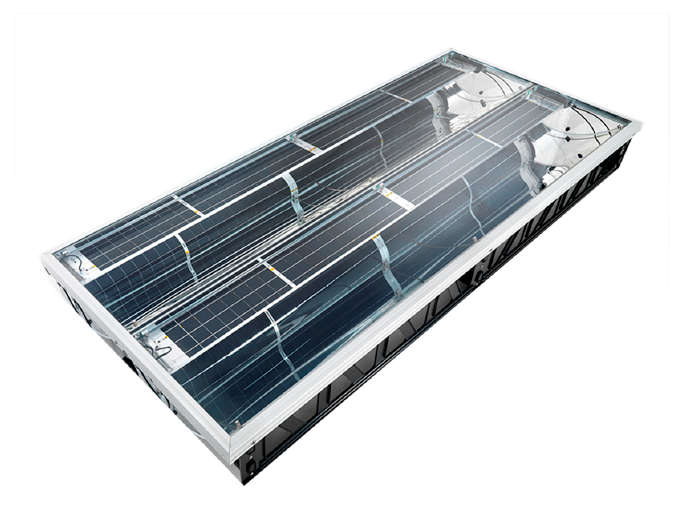
Figure 1. Solarus Power Collector.